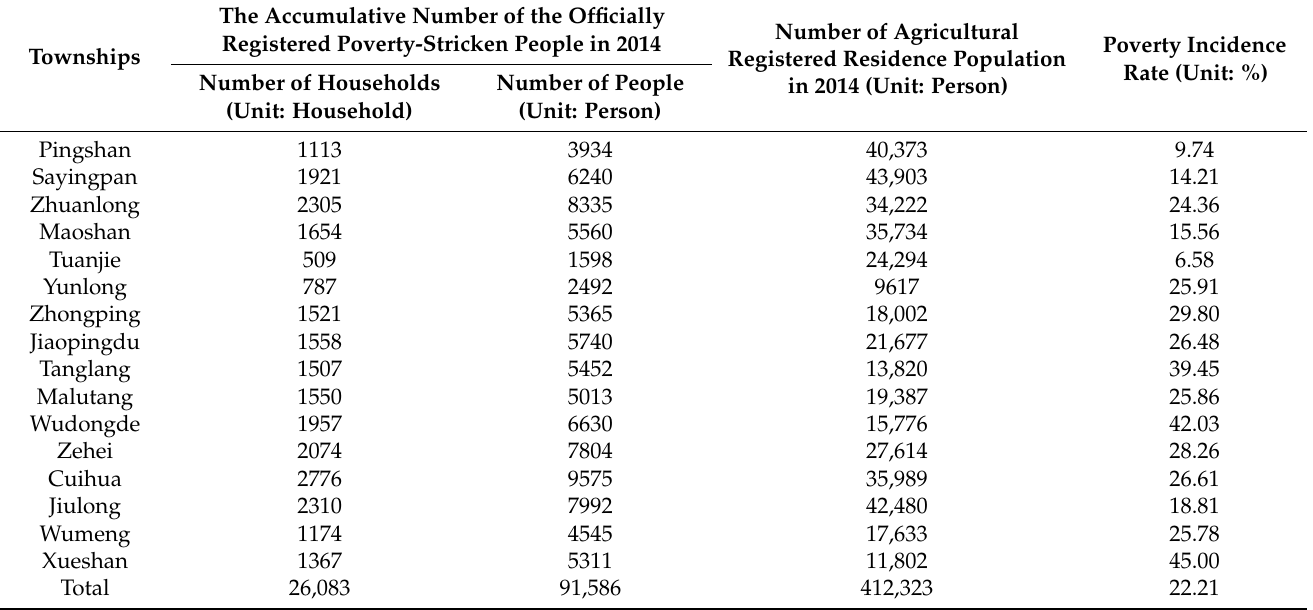
Table 2. Poverty Population and Poverty Incidence Rate in 2014 in Luquan